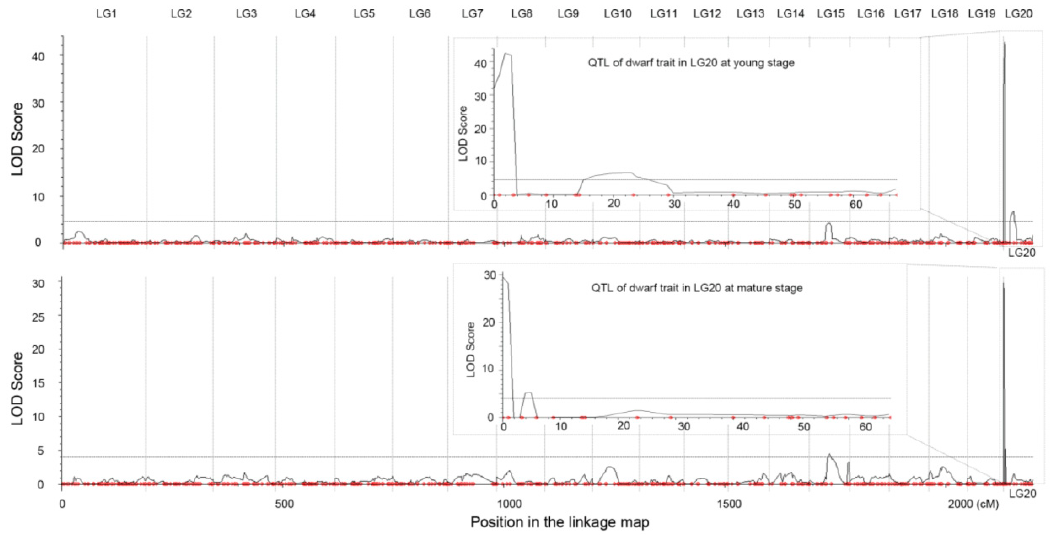
Figure 3. Mapping of quantitative trait loci (QTLs) controlling dwarf traits in the young ( top ) and mature ( bottom ) developmental stages. Curve in plot indicates the LOD score. The boxes inside showed the zoom-in view of the peak on LG20. The molecular markers located in the genetic map were represented by red dots.